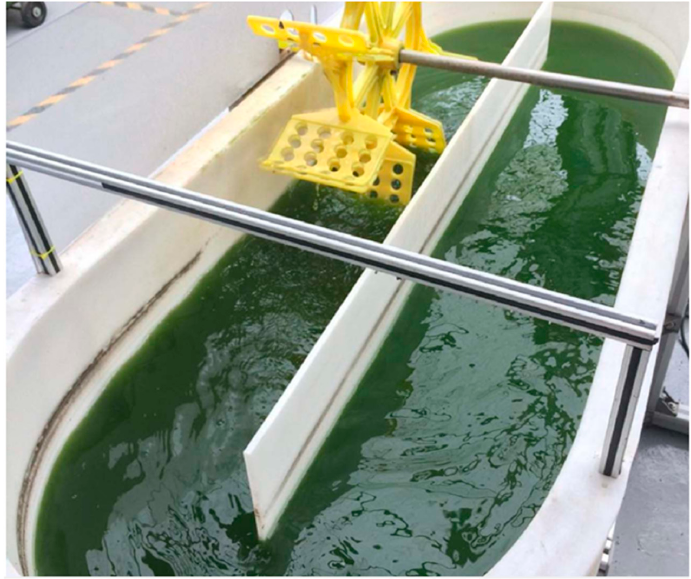
Figure 2. Example of a raceway pond wastewater treatment [59].